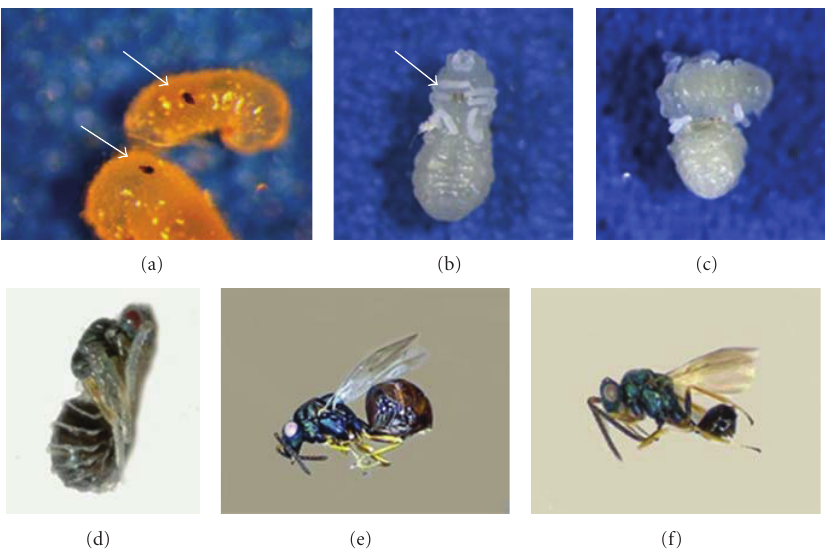
Figure 8: Life cycle of Orasema . (a) Planidia (arrows) attached to ant larvae. (b) First-instar larva (arrow). (c) Developed larva (ant larva behind). (d) Pupa. (e) Adult female. (f) Adult